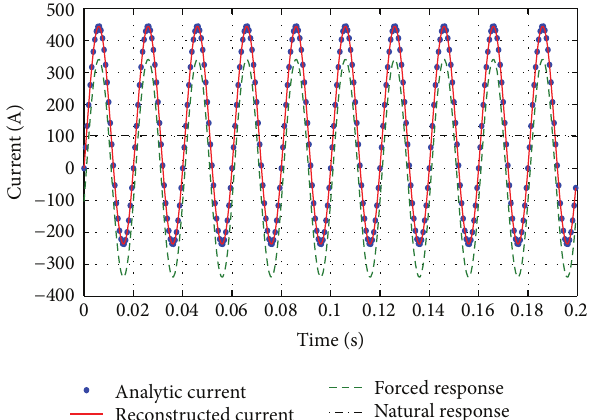
Figure 3: The analytic and reconstructed currents of the parallel RL circuit along with its forced and natural